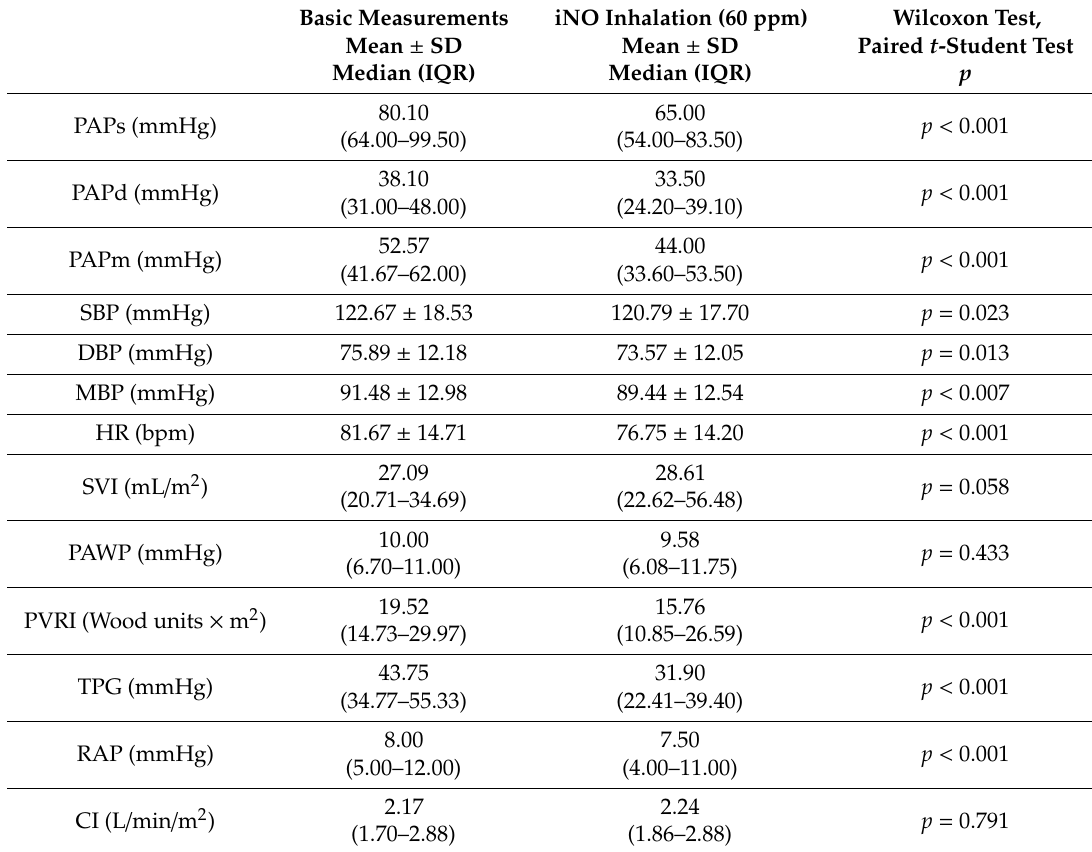
Table 2. Nitric oxide pulmonary reversibility test results in all